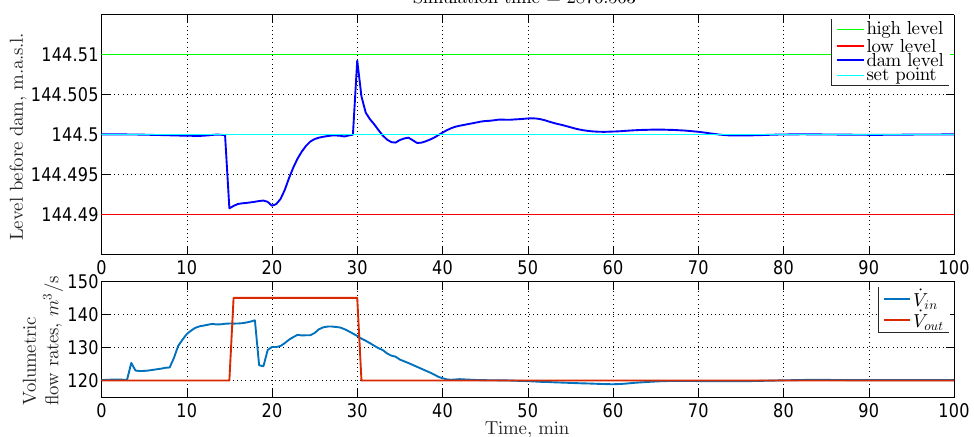
Figure 14: The results of simulation of MPC with later disturbance( λ e = 2 · 10 8 , N = 24 and T s = 30).